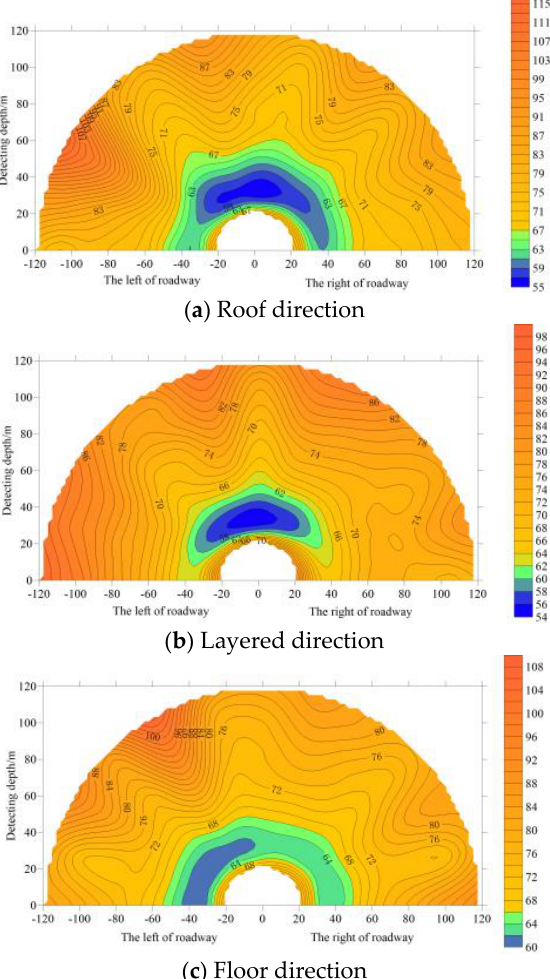
Figure 11. Detection results before grouting.